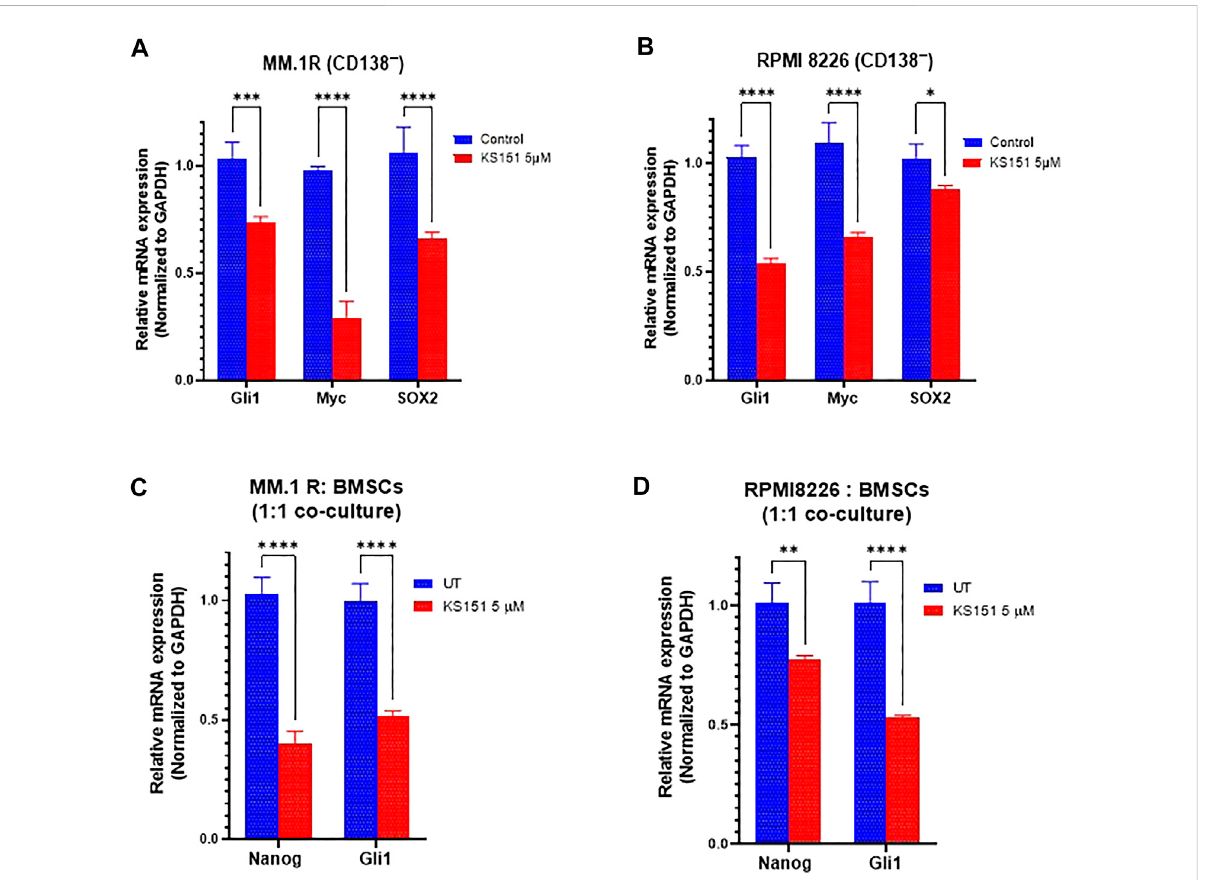
FIGURE 7 EffectofKS151onstemnessmarkers. (A-B) ,TheeffectofKS151onCD138 − stemnessmarkers.MM.1RCD138 − andRPMI8226CD138 − cellswere isolated using magnetic beads and treated with 5 μ M KS151 for 24 h then RNA was isolated, and RT-qPCR was performed using mentioned primers. (C-D) ,TheeffectofKS151onstemnessmarkerswhenMM.1RorRPMI8226wereco-culturedwithBMSCs.Weplated2×10 5 stromalcellsinsixwell- plate for overnight, then 2 × 10 5 MM.1R or RPMI 8226 were added to them and treated with 5 μ M of KS151 for 24 h. RNA was isolated and RT reaction was followed by a qPCR. Two-way ANOVA was used to determine statistical signi fi cance. Each data point is the average of three